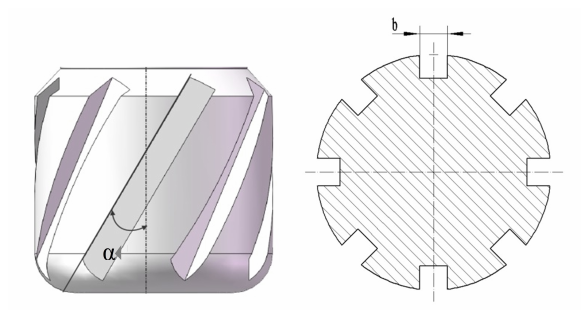
Fig. 5. Structural diagram of plunger spiral